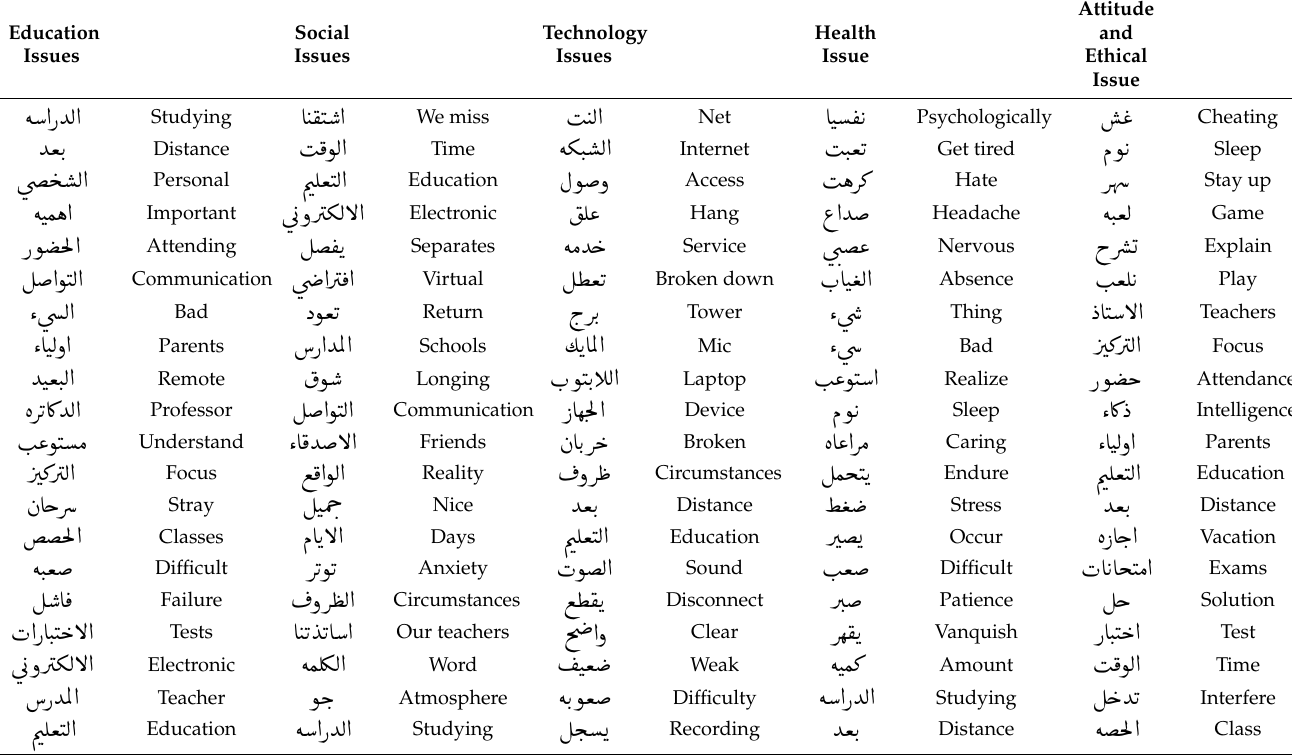
Table 3. The top 20 terms for each of the general